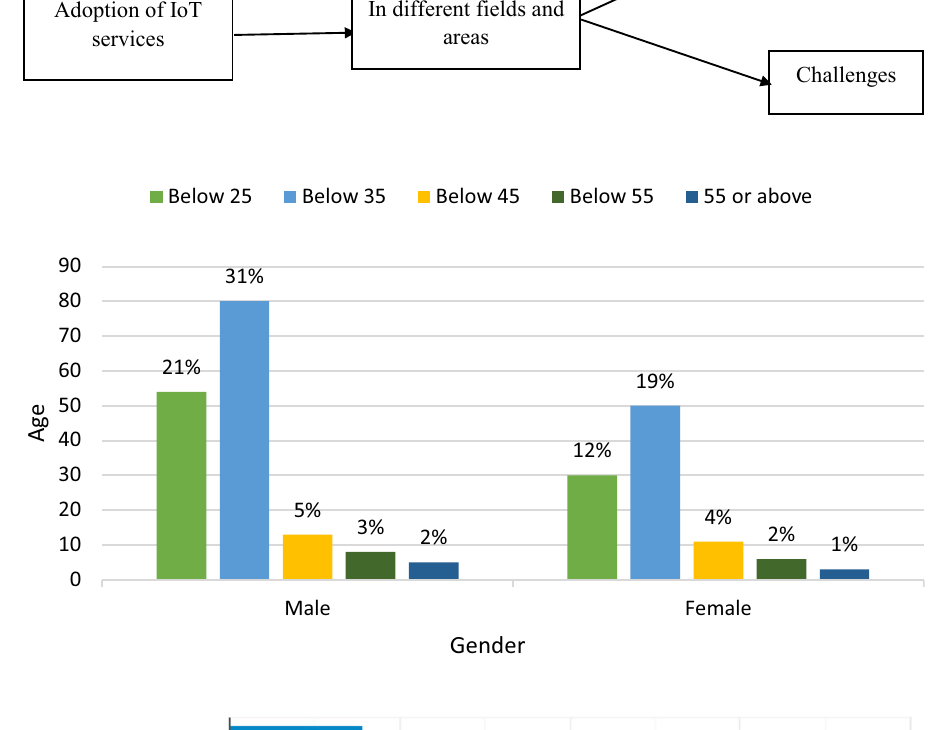
Fig. 6 Participants’ age